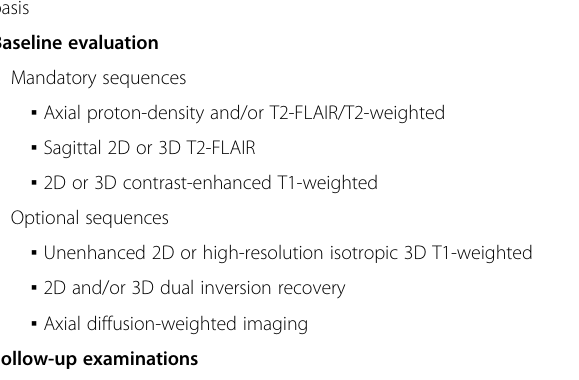
Table 1 Standardised protocol for brain MRI Brain MRI is important for achieving a prompt, accurate diagnosis of MS. Here we present a standardised protocol for the evaluation of patients with suspected or clinically definite MS; however, the precise sequences and timing of follow-up scans must be determined on a case-by-case